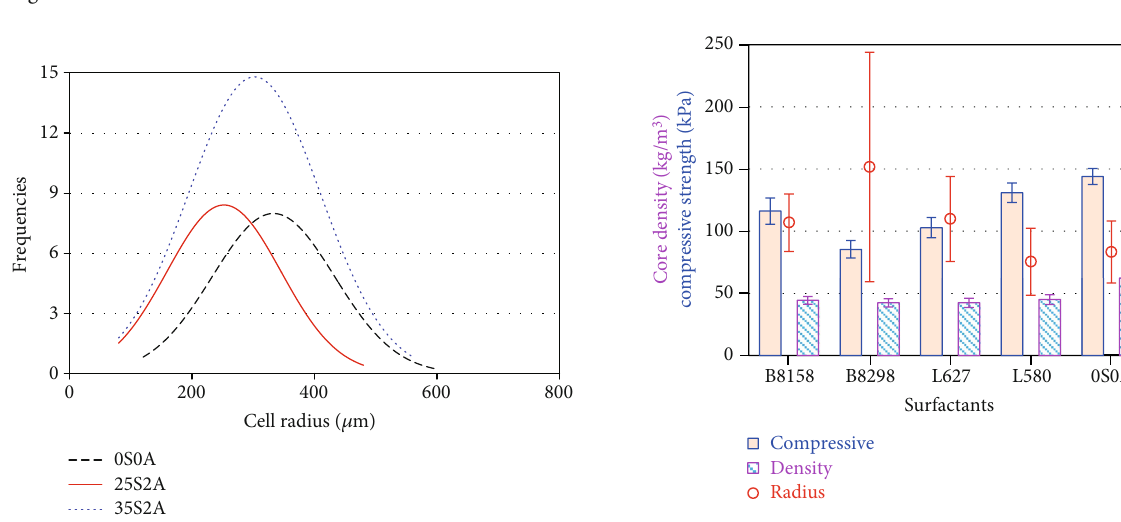
Figure 3: The e ff ect of silicone and amine content on the properties of rigid PU